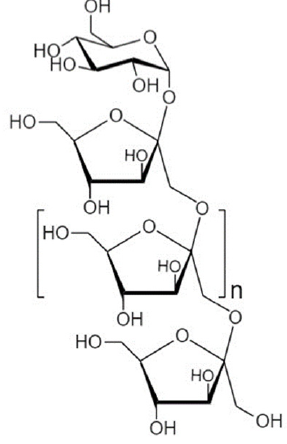
Figure 3. FOS structure: the main components of FOS are n 2,1- or 2,6-linked β - D -fructose monomers and a terminal 1,2-linked α - D -glucose. FOS, fructooligosaccharides.